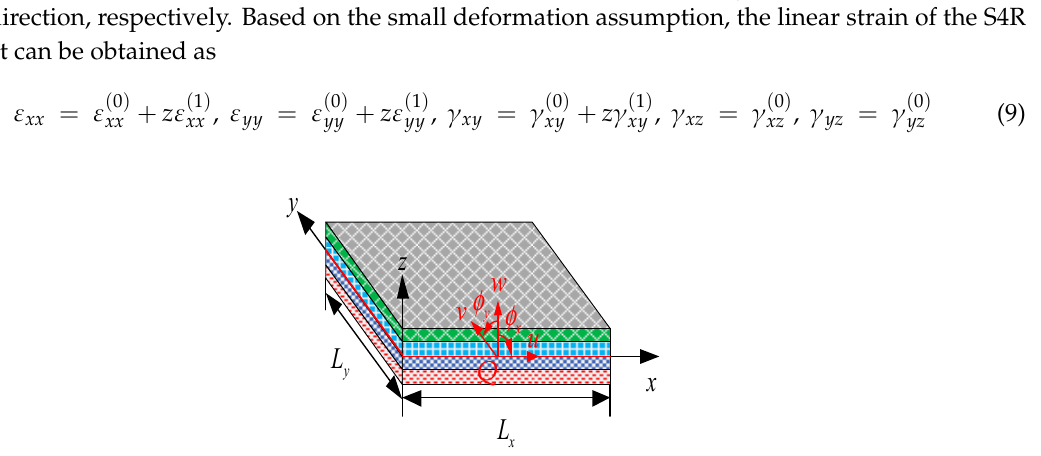
Figure 6. Schematic diagram of the element coordinates.